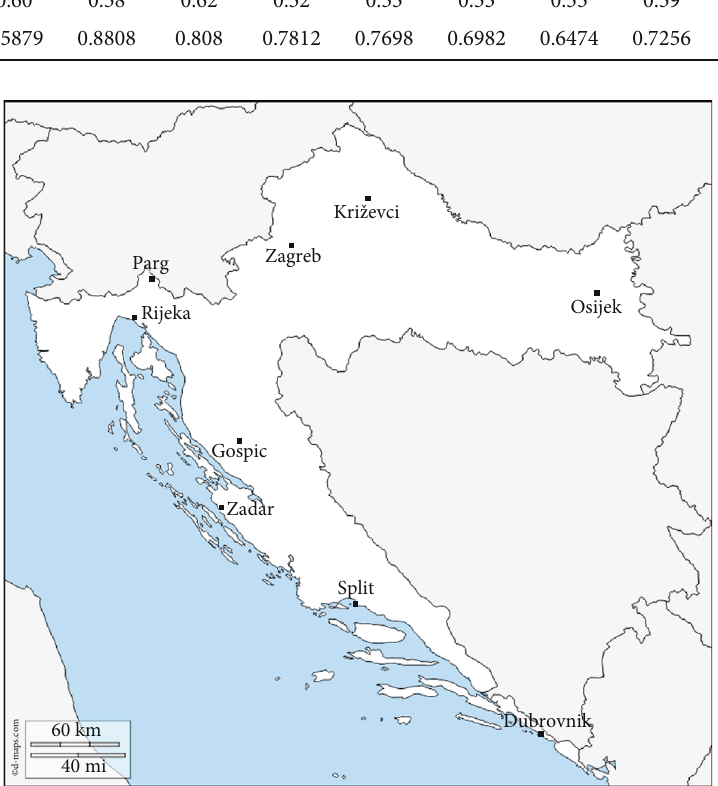
Figure 1: The map of Croatia showing meteorological stations where sunshine duration and solar radiation are measured [26].